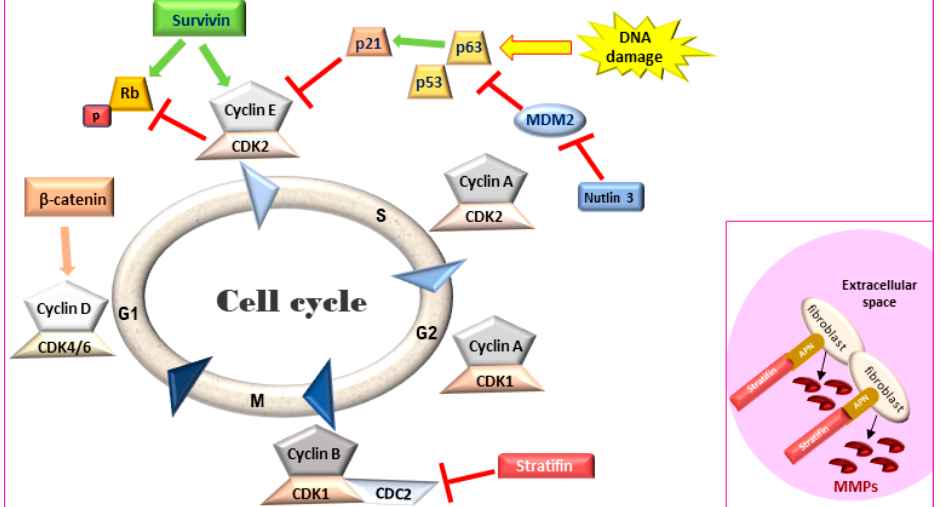
Figure 1. Cell cycle regulation. Survivin leads to an accelerated S phase and phosphorylates Rb thereby blocking its action. Stratifin blocks CDK1-Cyclin B complex causing G2/M arrest. Inset: In the extracellular space, stratifin can bind to aminopeptidase N (APN) on the plasma membrane of stromal fibroblasts and lead to the production of matrix metalloproteinases (MMPs). Rb: retinoblastoma, MDM2: mouse double minute 2 homology, CDK: cyclin-dependent kinase.